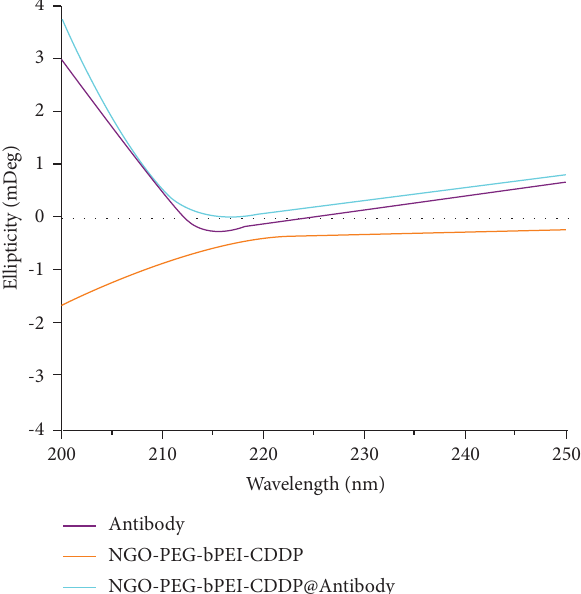
Figure 4: CD spectra of Antibody, NGO-PEG-BPEI-CDDP, and NGO-PEG-BPEI-CDDP@Antibody. Te CD spectra of free squamous cell carcinoma antibody, NGO-PEG-BPEI-CDDP, and NGO-PEG-BPEI-CDDP@Antibody in aqueous